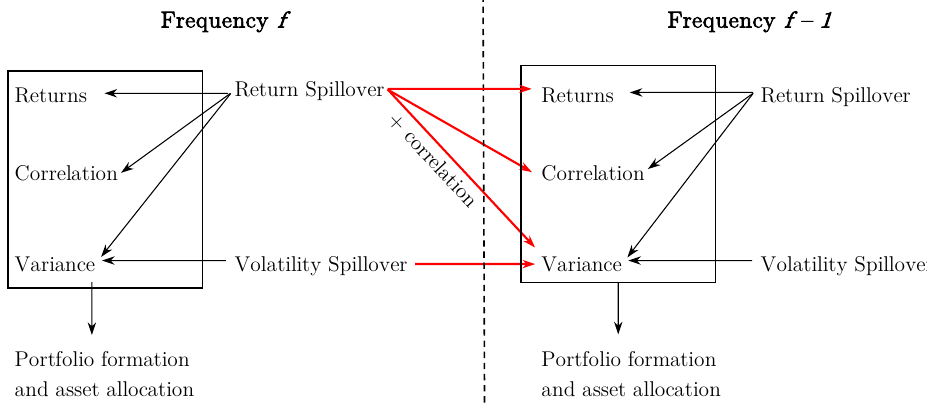
Figure 9. Channels of the links between spillovers and asset allocation. This figure illustrates that return spillovers affect expected returns, correlations and variances, while volatility spillovers affect variances, at both same frequency f and lower frequency f − 1. The figure also demonstrates that spillovers are embedded in returns, correlations and variances rendering them redundant for portfolio formation and asset allocation. Volatility spillovers may affect returns and correlation through a volatility feedback effect but the primary link is through the